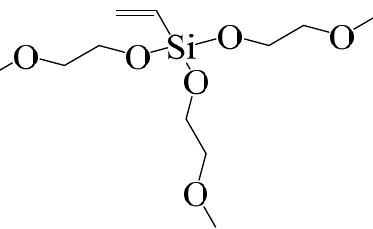
Figure 1. Molecular structure of vinyl triethylene (b-methoxy ethoxy) silane (VTMES).